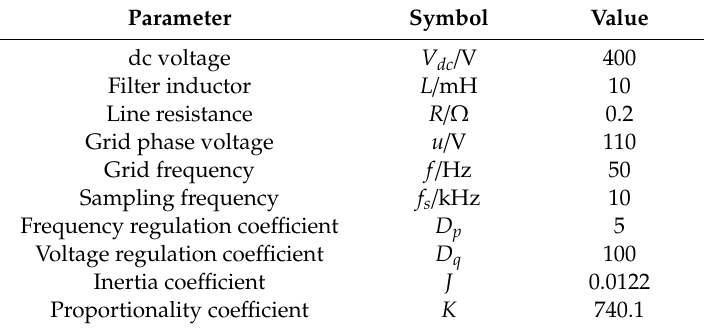
Figure 10. Experimental setup for a three-phase converter. Table 2. Experimental parameters.